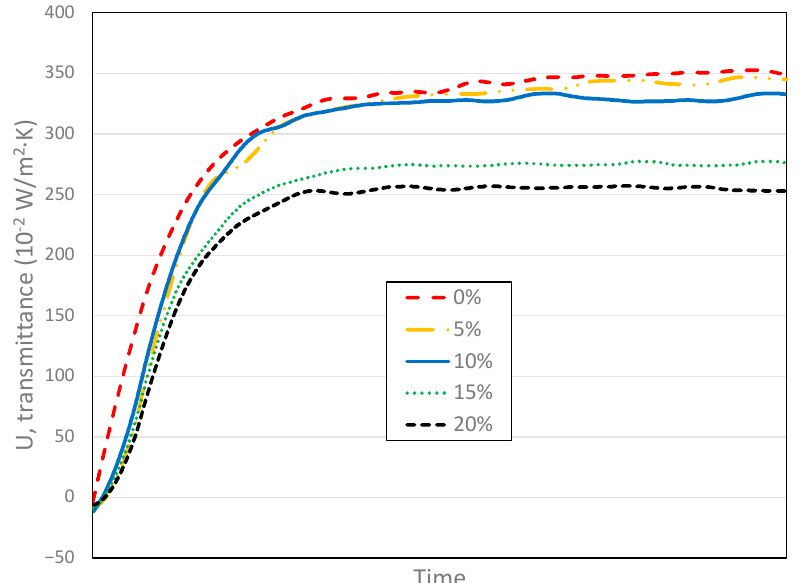
Figure 10. Continuous U-value evolution measured with aHB instrument using samples with different iron oxide concentrations.